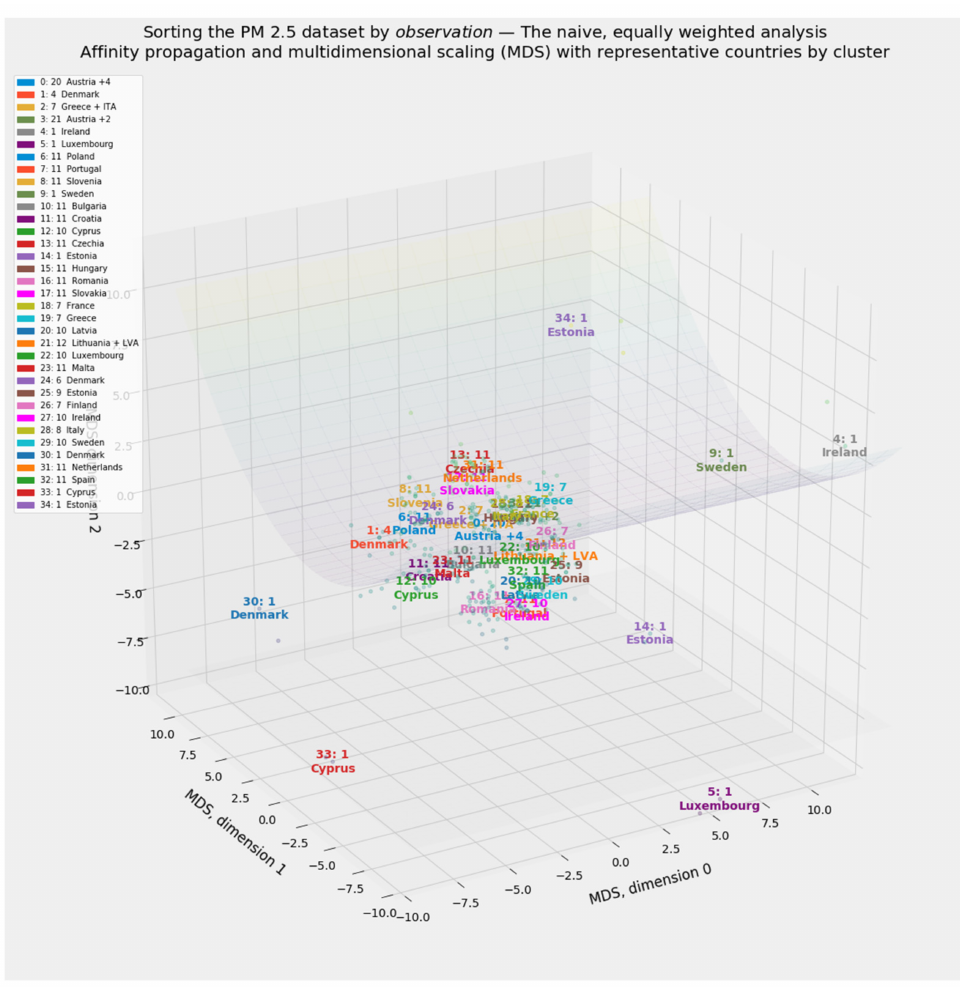
Figure 10. Clusters of observations within the PM 2.5 dataset based on naïve, unweighted